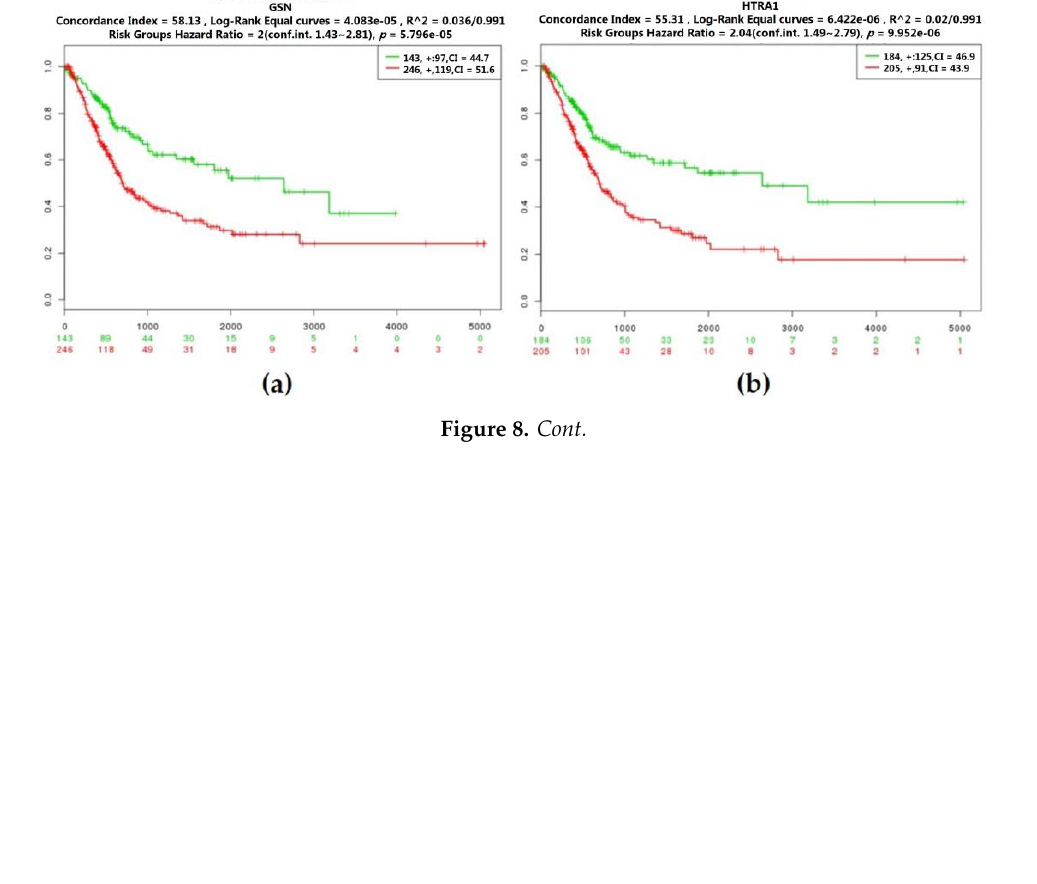
Figure 8. Overall survival of the co-expression of hub genes of bladder cancer with grade 3 carcinoma based on Kaplan–Meier plotter. The horizontal axis represents the time to event. The patients were stratified into the high-level group and low-level group and labeled with color. The red line indicates the samples with high risk, and the green line shows the samples with low risk. p < 0.05 is considered a statistically significant difference in mortality between the high-level group and low-level group. ( a ) Gelsolin (GSN); ( b ) HtrA serine peptidase 1 (HTRA1); ( c ) PDZ and LIM domain 5 (PDLIM5). 2.4. Identification of Candidate Genes with High Weighted Degree Score Highly connected hub genes were defined by module connectivity (ModuleMembership > 0.8) and clinical trait relationship (GeneSignificance > 0.2). The hub genes of each module were visualized as networks in Gephi and screened out the top candidate gene by in-rank ordering of betweenness score for further analysis (http://www.funrich.org/) (Figure 9).